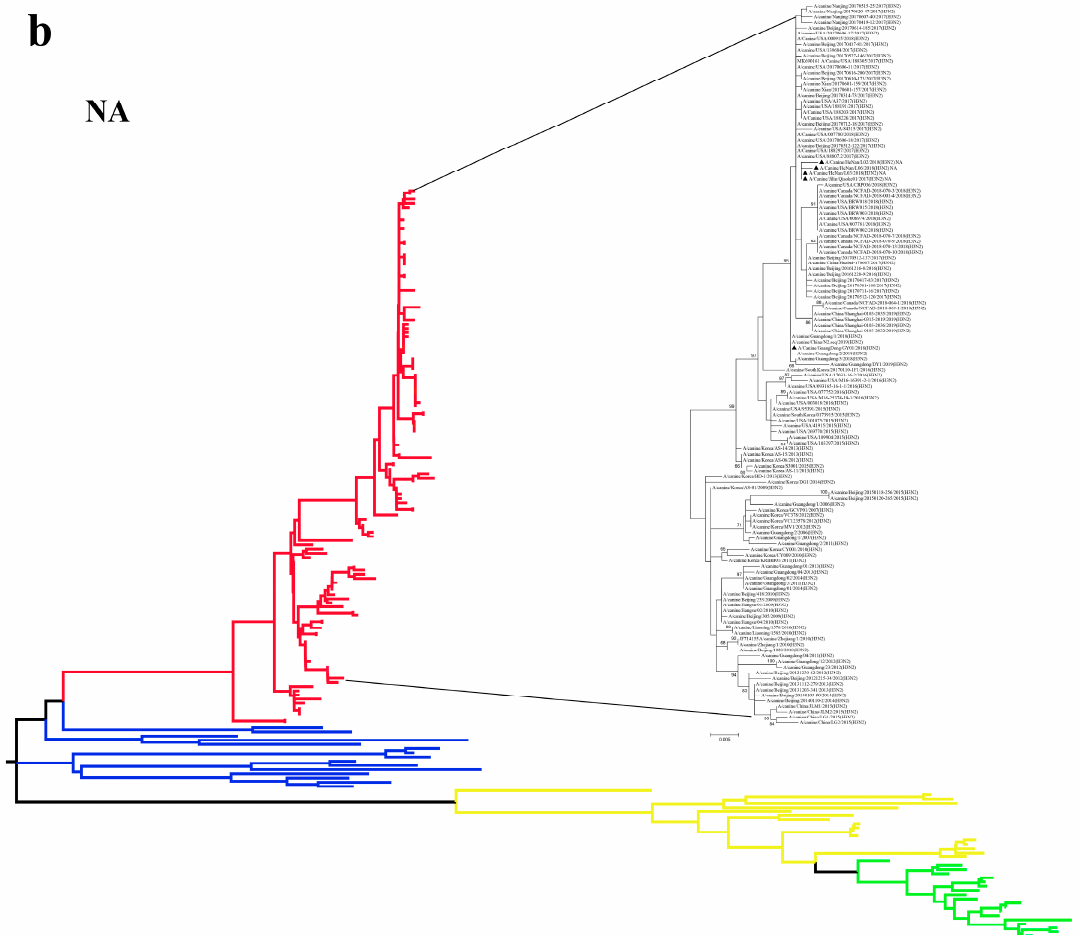
Figure 1. Phylogenetic tree of HA and NA sequences of H3N2: ( a ) phylogenetic tree of HA sequences of H3N2. ( b ) Phyloge- netic tree of NA sequences of H3N2. Red, blue, yellow, and green branches represent isolates from dogs, avian, swine, and humans, respectively. Black circles represent the strains in this